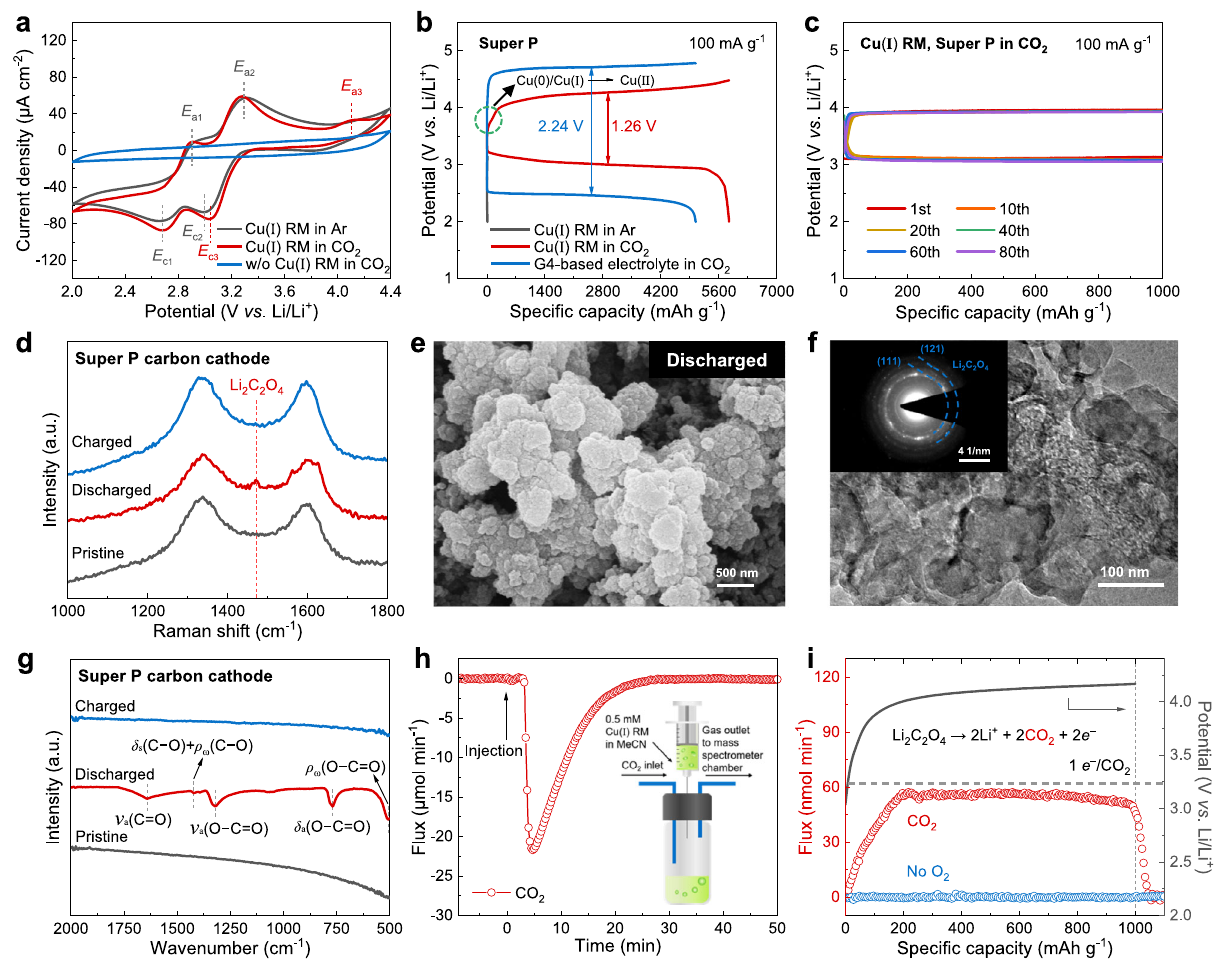
Fig. 2 | Electrochemical performance, cathode characterization, and CO 2 quanti fi cationofLi – CO 2 batterieswithCu(I) RM-based electrolyte.a CVcurves for cells with various electrolytes and atmospheres: 0.5mM Cu(I) RM in 0.1M LiClO 4 /MeCN under Ar (dark gray), 0.5mM Cu(I) RM in 0.1M LiClO 4 /MeCN under CO 2 (red), and 0.1M LiClO 4 /MeCN under CO 2 (blue). Scan rate is 20mVs − 1 . b Galvanostatic discharge-charge curves for Super P carbon cathodes in various electrolytes and atmospheres: 0.5mM Cu(I) RM in 0.1M LiClO 4 /MeCN under Ar (dark gray), 0.5mM Cu(I) RM in 0.1M LiClO 4 /MeCN under CO 2 (red), and 1M LiTFSI/G4underCO 2 (blue).Current density is 100mAg − 1 . c Cyclic